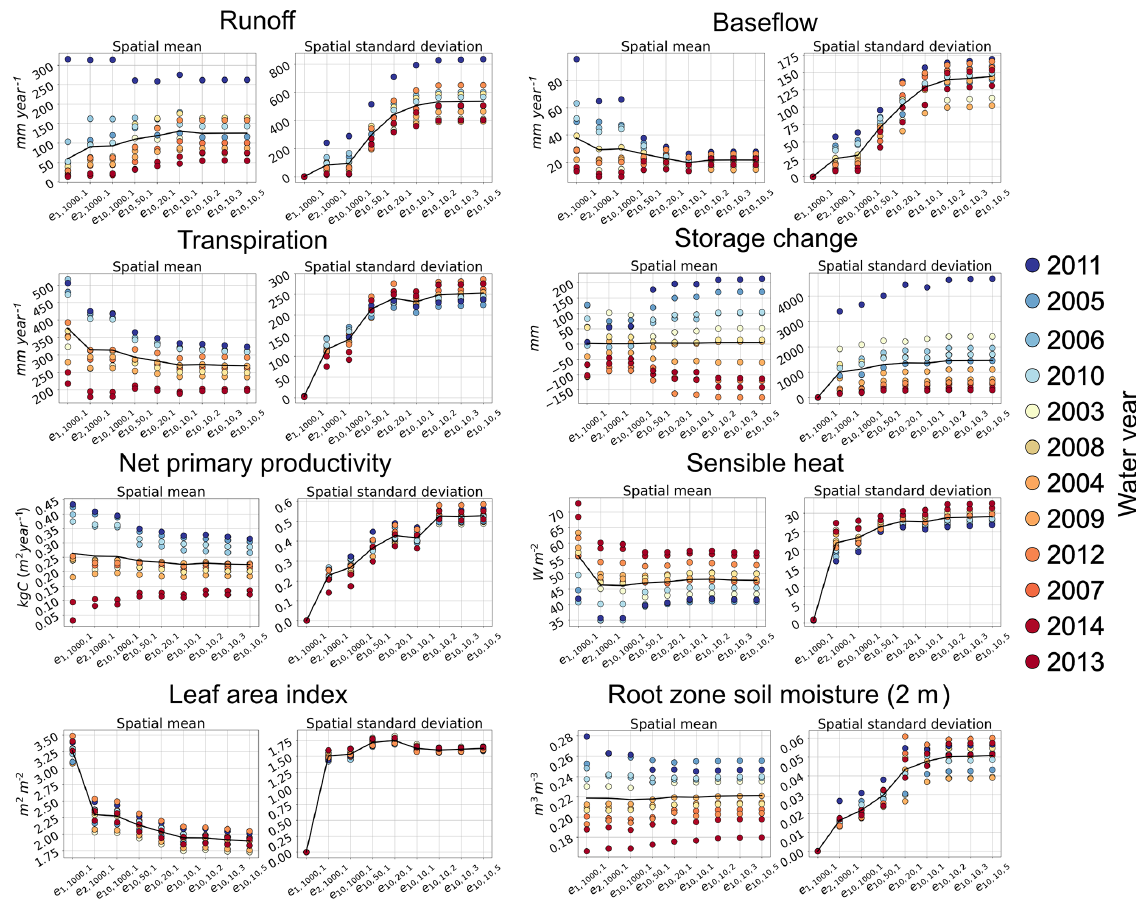
Figure 9. Comparison of the model experiments in Table 1. For each experiment, the spatial mean and spatial standard deviation for all water years (1 October–30 September) between 2003 and 2014 are plotted for a suite of states and fluxes. The corresponding values for each water year are color-coded according to their precipitation. The black line shows the annual mean.